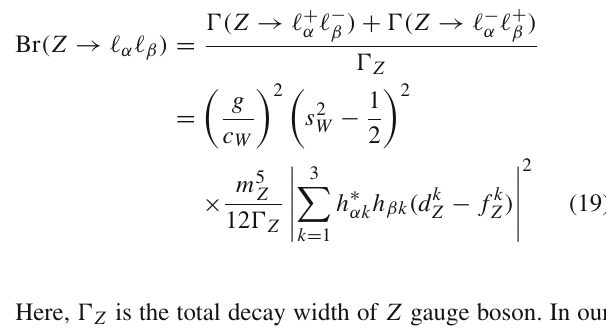
representing the decays Z , H → (cid:2) α (cid:2) β . In these diagrams, wavy line corresponds to either Z gauge boson or Higgs